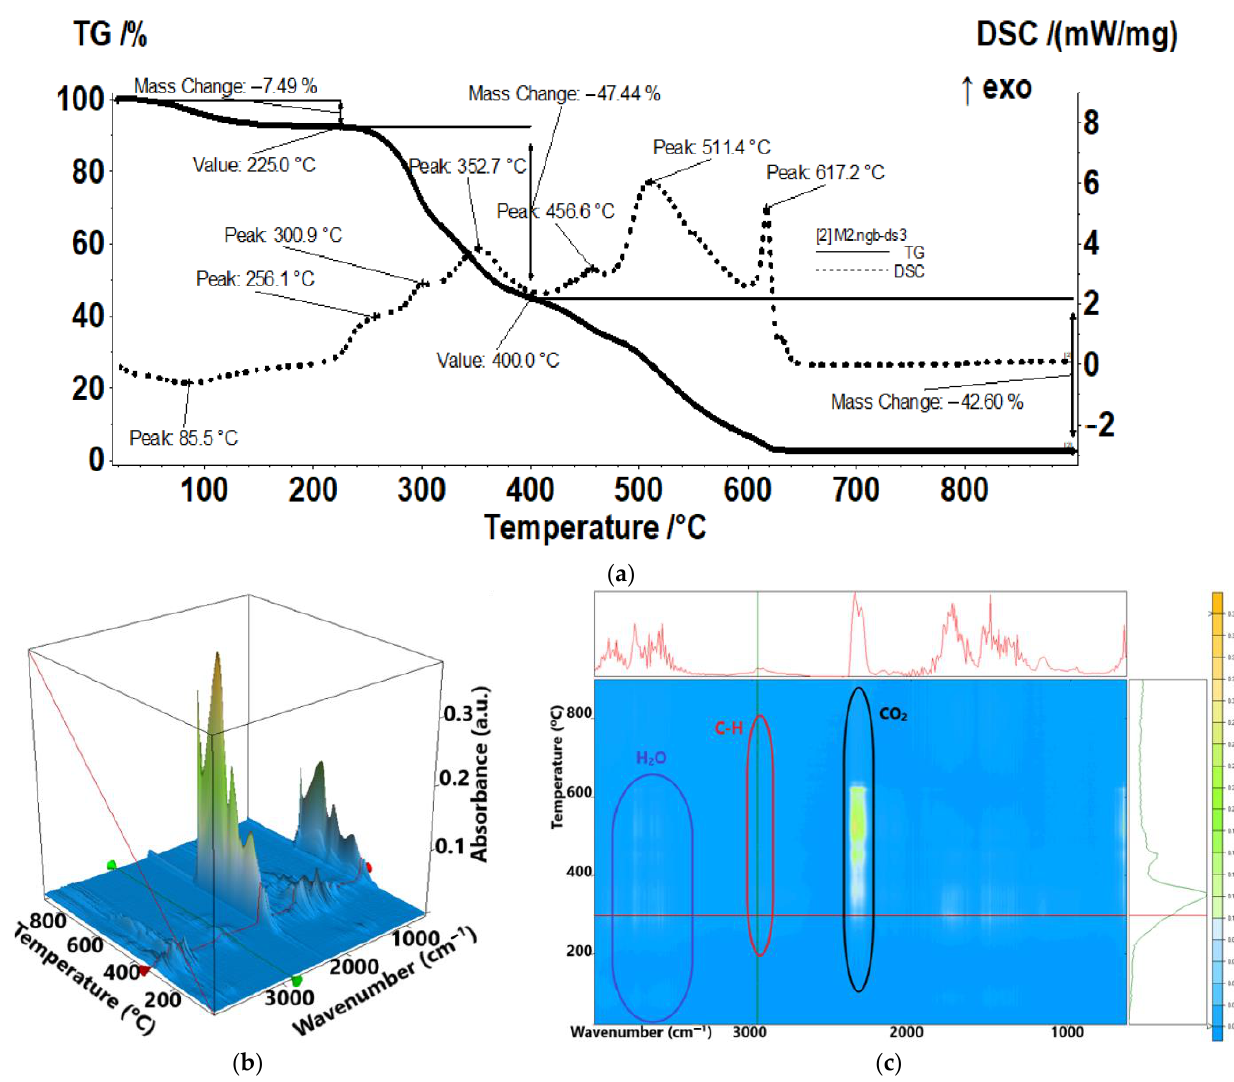
Figure 11. Thermal characteristics of the chitosan–sulfonated ethylene-propylene-diene terpolymer membranes (Chi-sEPDM) (M2): ( a ) thermal diagram, ( b ) 3D complex analysis; ( c ) 2D complex analysis.